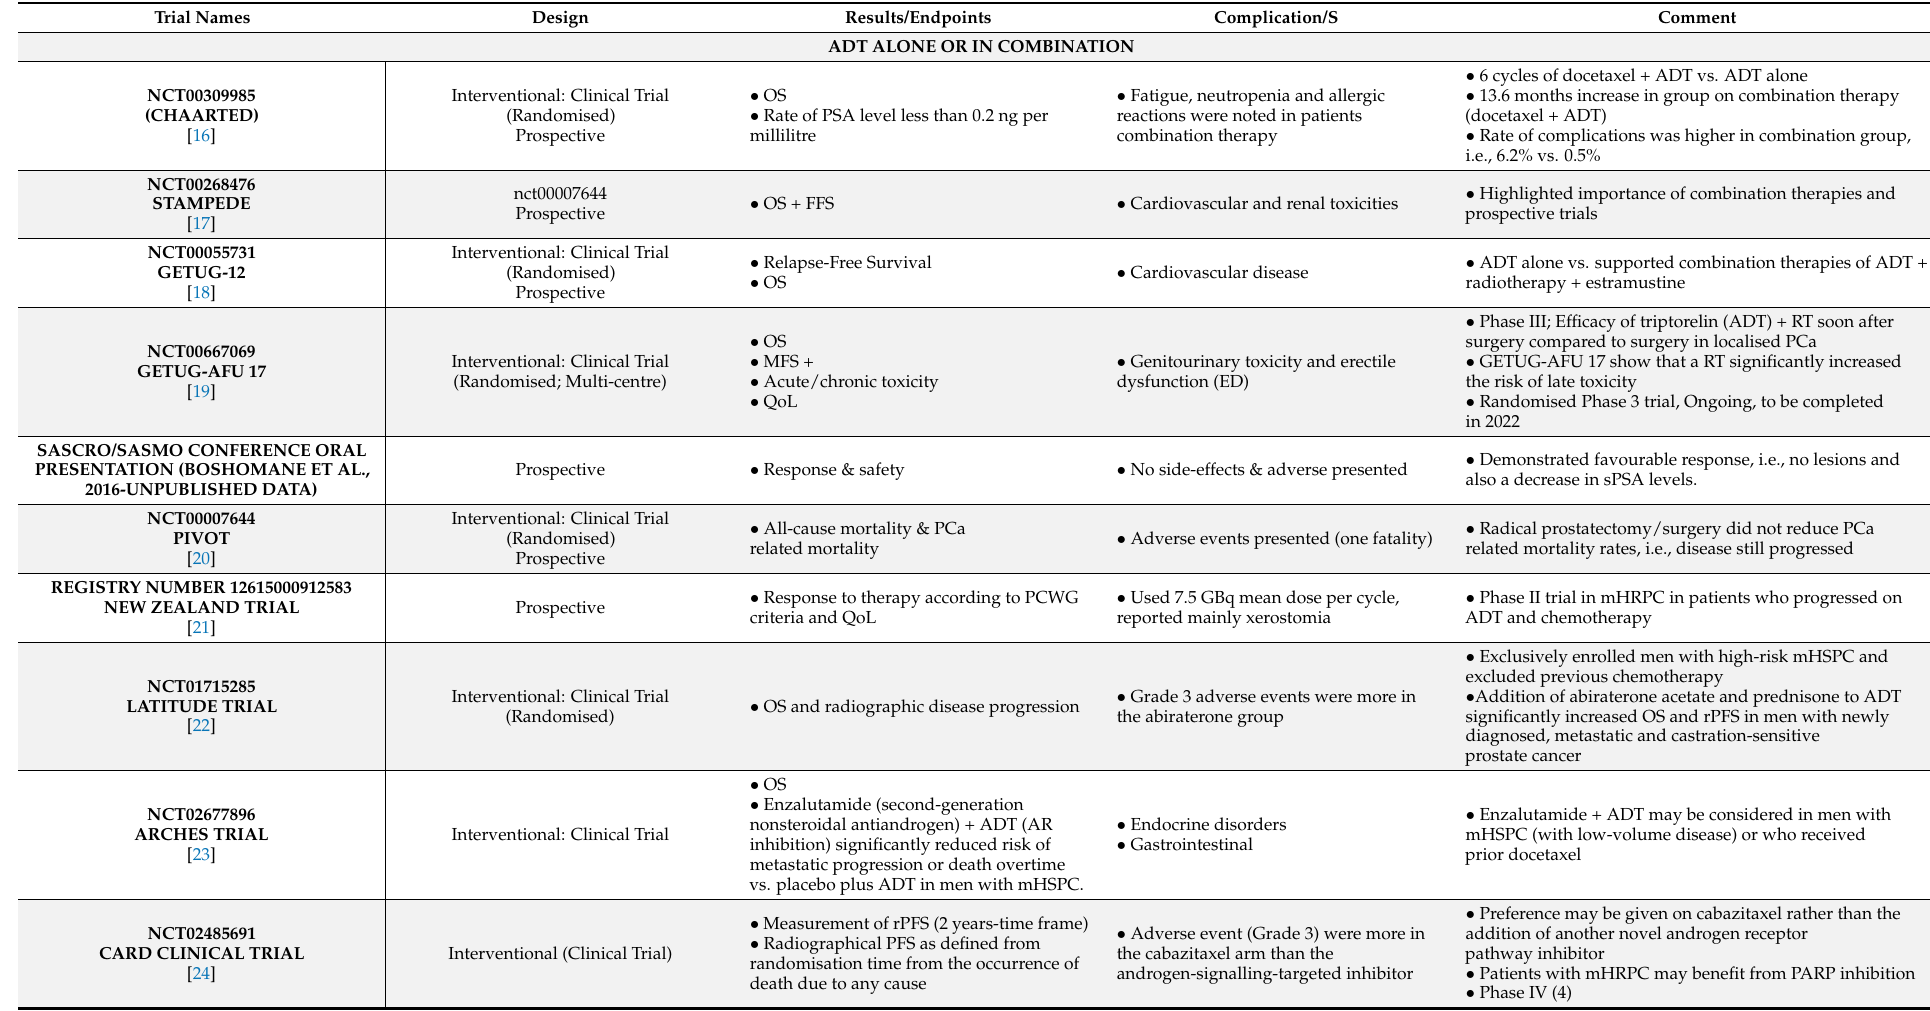
Table 1. Summary of key trials and studies in the treatment of PCa